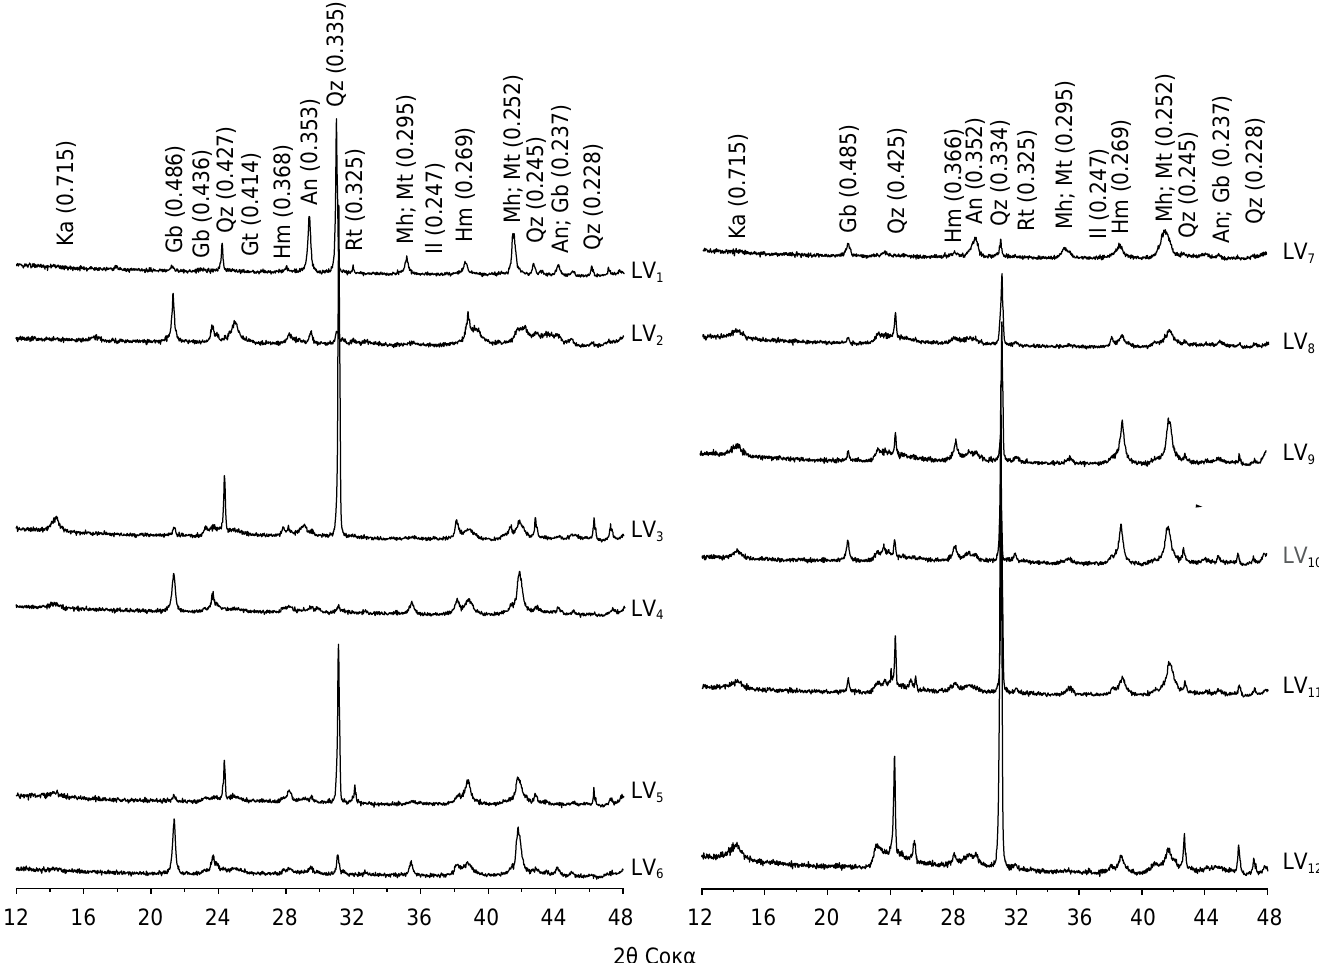
Figure 3. X-ray patterns from silt fraction (powder method) of the soils. Ka: kaolinite; Gb: gibbsite; Qz: quartz; An: anatase; Hm: hematite; Gt: goethite; Mh: maghemite; Mt: magnetite; Rt: rutile; and Il: ilmenite. Numbers between parentheses correspond to distance between adjacent planes in nanometers (nm) expressed in three decimal places. LV 1 , LV 3 , LV 4 , LV 5 , LV 6 , LV 8 , LV 9 , LV 10 , and